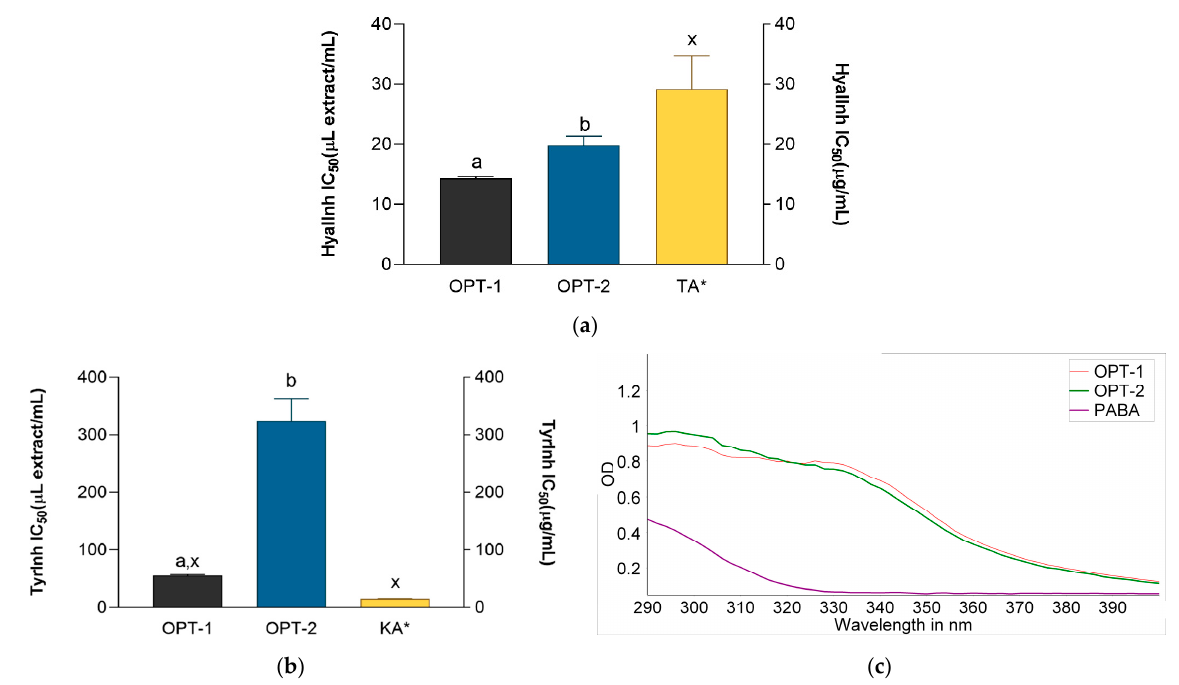
Figure 4. Hyaluronidase ( a ) and tyrosinase ( b ) inhibitory activity of the OPT-1 and OPT-2 extracts (prepared as described in Section 2.6) and positive controls KA (kojic acid) and TA (tannic acid) and UV-spectra of OPT-1 (red line), OPT-2 (blue line), and 1 mg/mL p -aminobenzoic acid (PABA) solution ( c ) in 1:64 dilution. a,b = differences between the extracts within a column (Student’s t -test, p < 0.05). x = differences with the positive control (ANOVA followed by Dunnett’s post-test, p < 0.05). Columns not connected with the same letter are statistically different. The asterisk indicates that the unit is placed at the right ordinate.